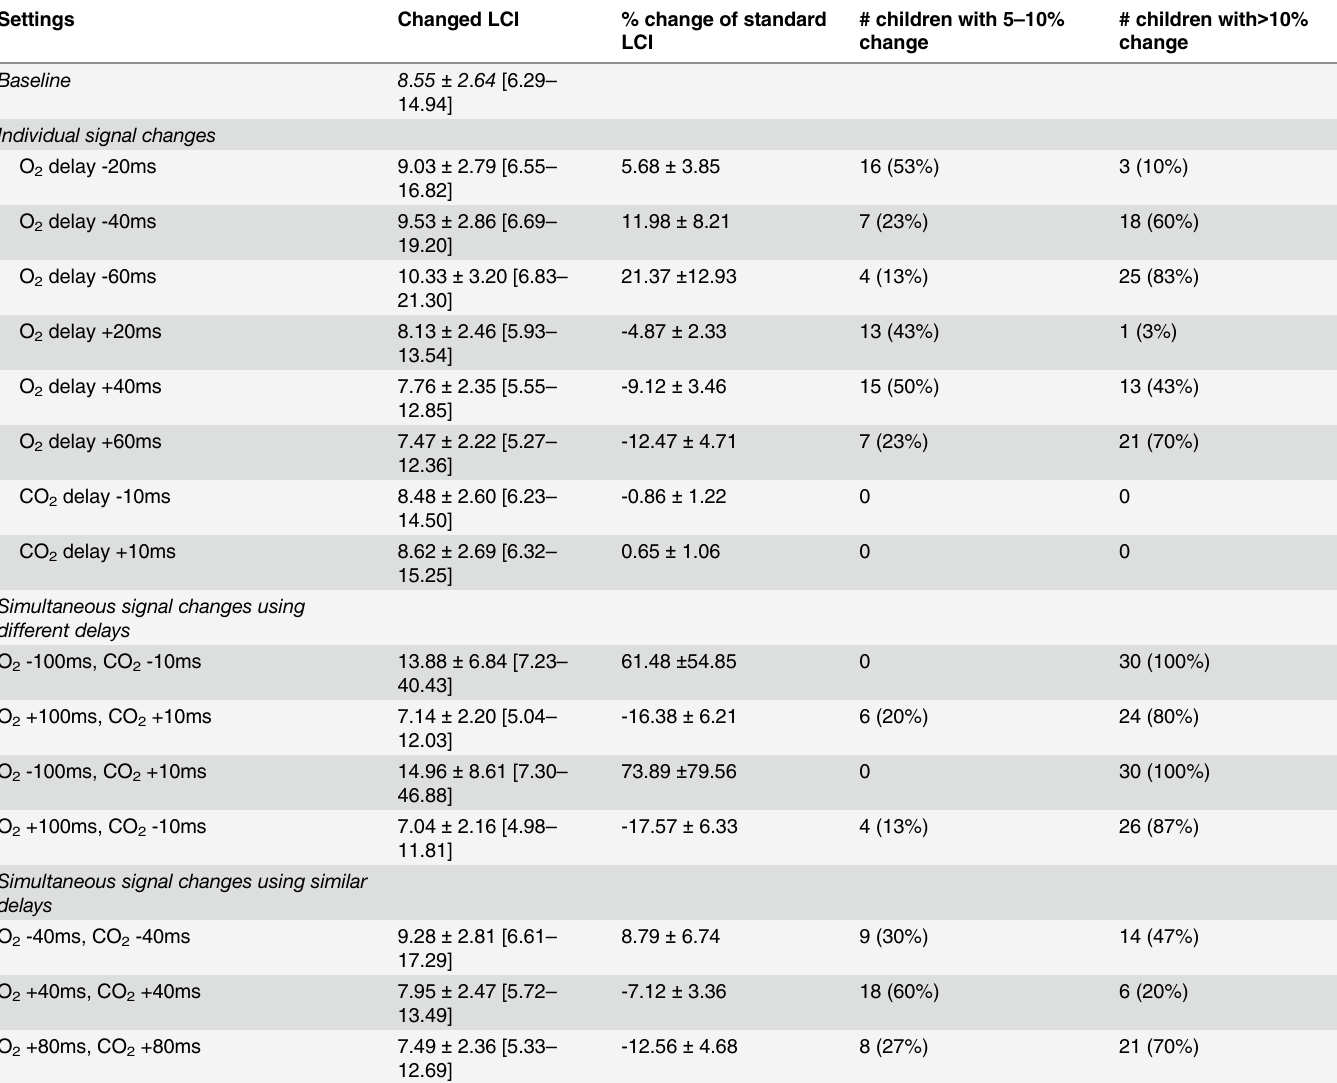
The table shows mean ± SD [range] LCI after reanalysis of the tests with changed signal delay times, mean ± SD change in percentage of standard LCI, number of children with a change between 5 – 10% and children with > 10% change of standard LCI. Of note, for simultaneous signal changes using similar time steps, delays between O 2 and CO 2 sensor were kept